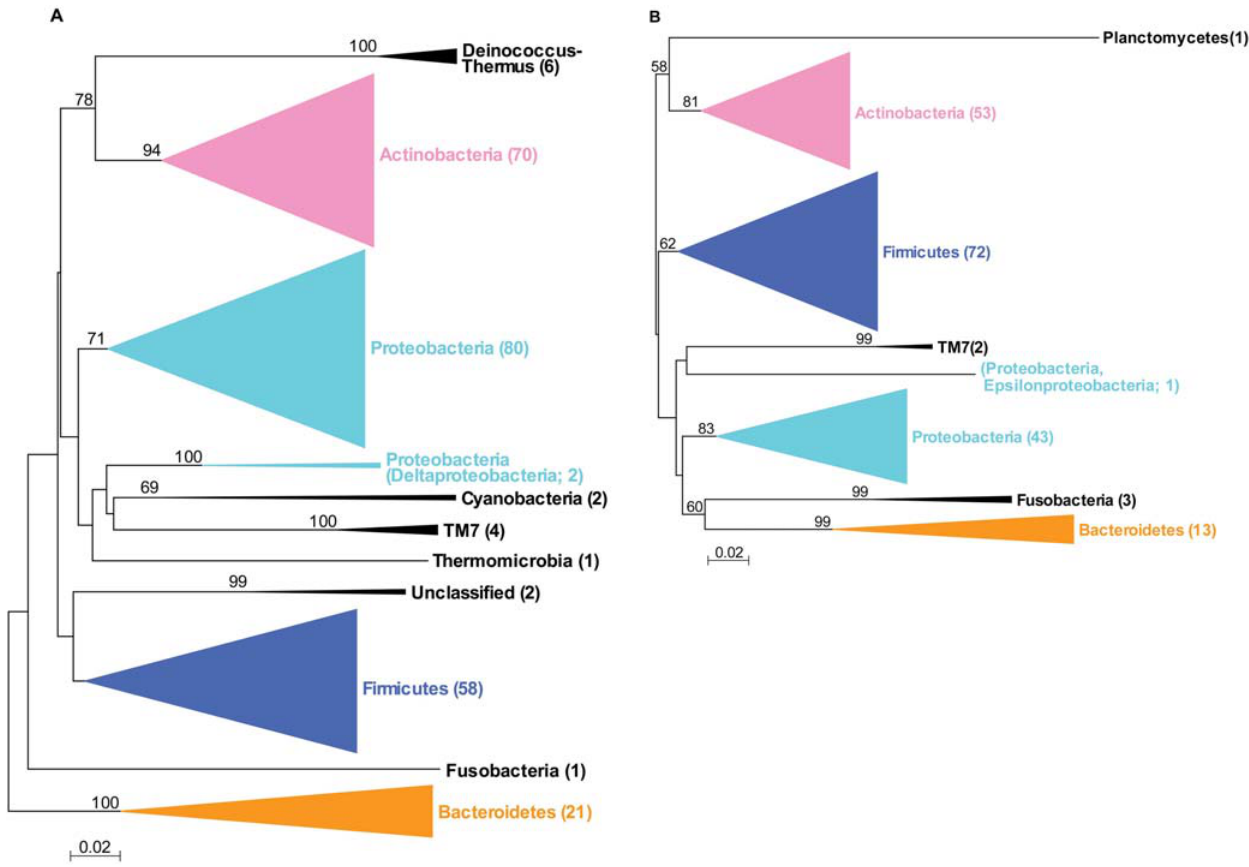
Figure 2. Phylogenetic analysis of bacterial 16S rDNA detected in 39 samples from human skin. From 3,963 clones, sequences representing 11 bacterial phyla and 366 SLOTUs were observed. The numbers in parentheses indicate the number of SLOTUs in each phylum. Alignments were done with Greengenes, and misalignments were manually in MEGA 4.0 [38], evolutionary distances were calculated with the Jukes– Cantor algorithm, and phylogenetic trees were determined by the Neighbor-Joining method; with 1,000 trees generated, bootstrap confidence levels are shown at tree nodes for values $ 50%. Panel A: Phylogenetic analysis of 20 samples from 6 healthy subjects. Panel B: Phylogenetic analysis of 13 samples from the lesions of 6 patients with